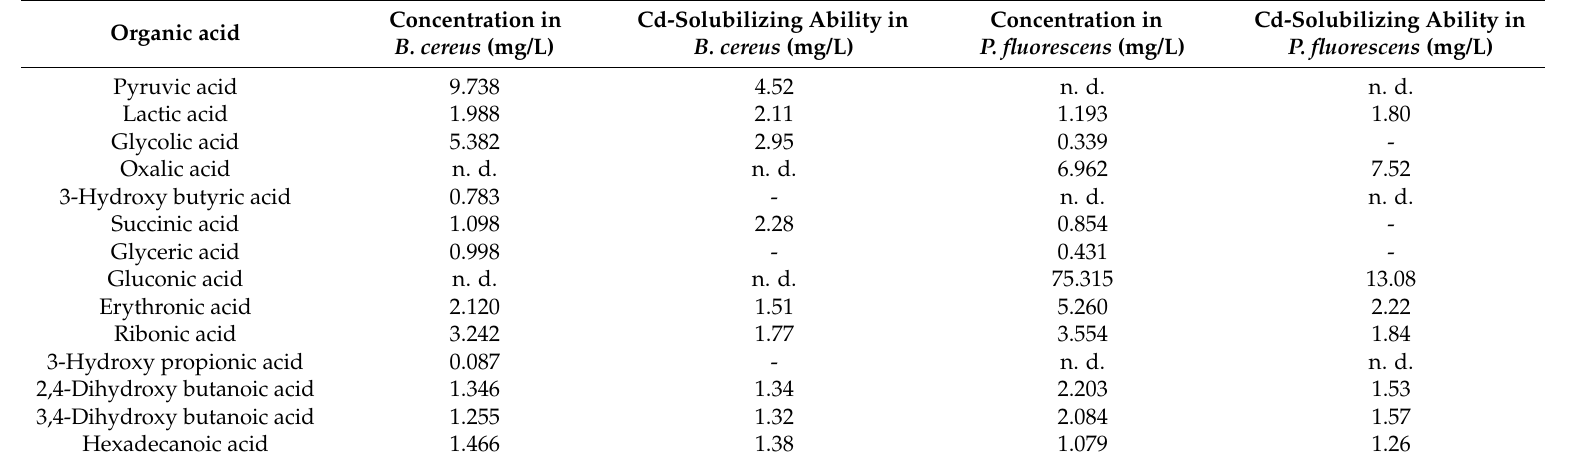
Table 3. Concentration and Cd-solubilizing ability of organic